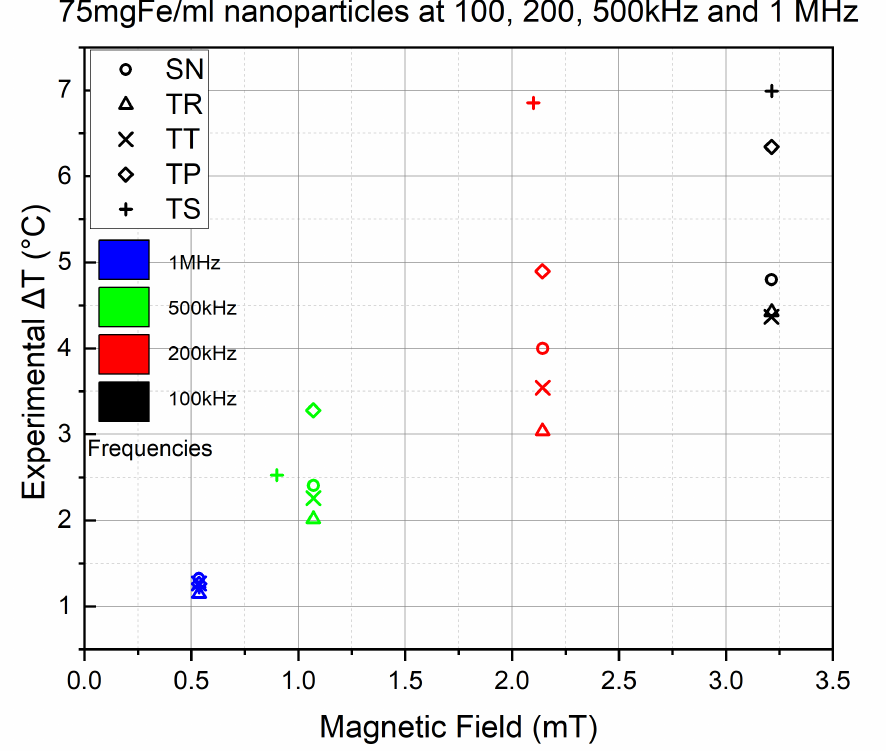
Figure 10. Comparing the 900 s experiment results of all signals at 0.53, 1.07 (except for TS at 0.890), 2.14 and 3.21 mT and 1 MHz, 500, 200 and 100 kHz frequency,